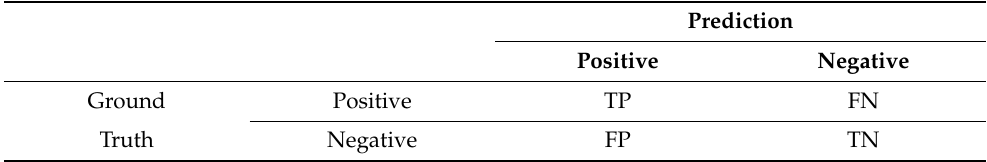
Table 1. Relationships between ground truth and prediction, which are represented by TP, FP, FN, and